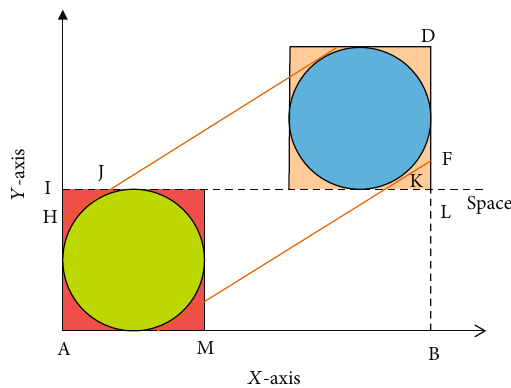
Figure 2: Collision geometry diagram in the same direction. Figure